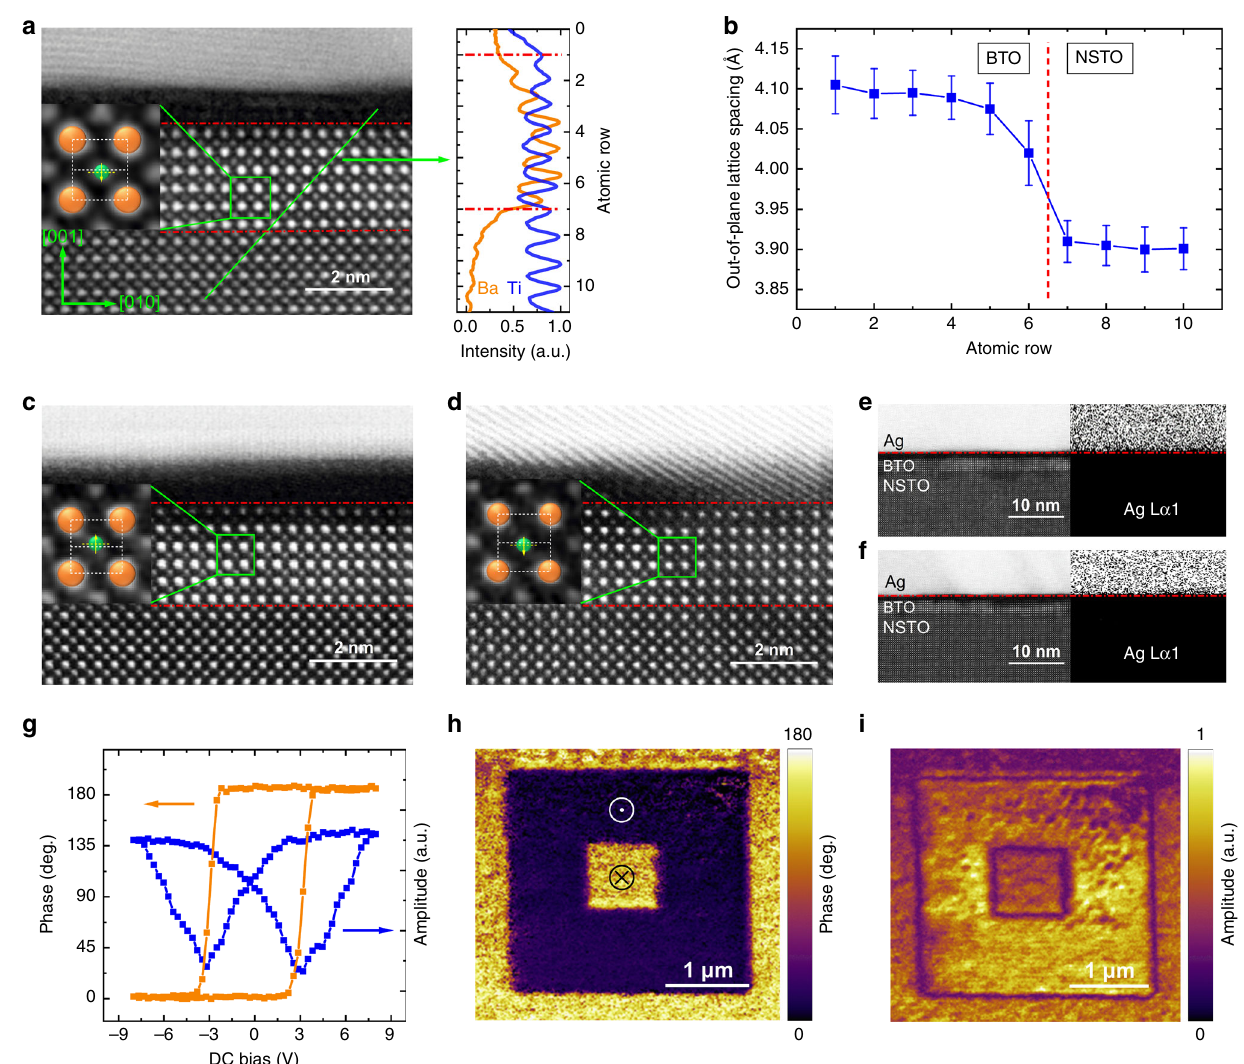
Fig. 1 Structural and ferroelectric properties. a Left panel: HAADF-STEM image of the Ag/BTO/NSTO FTJ at the virgin state with the inset showing the Ti ion displacement in BTO. The orange and green spheres denote Ba and Ti ions, respectively. Right panel: Elemental pro fi les obtained from the EELS of Ba and Ti elements. b Mean value of the out-of-plane lattice spacing near the BTO/NSTO interface. The error bars indicate standard deviations. c , d HAADF- STEM images of the FTJs after poling the ferroelectricity upward and downward by − 3 and + 3 V voltage pulses with t d = 100 ns. Insets show displacements of Ti ions. e , f Ag element distributions measured by the EDS mapping for FTJs after poling the ferroelectricity upward and downward. g PFM hysteresis loops in phase (orange) and amplitude (blue). h PFM phase and i PFM amplitude images recorded after writing an area of 3 × 3 μ m 2 with − 6 V and then the central 1 × 1 μ m 2 with + 6 V by a biased conductive